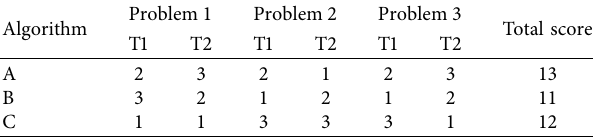
Table 4: Reward points and total score of all